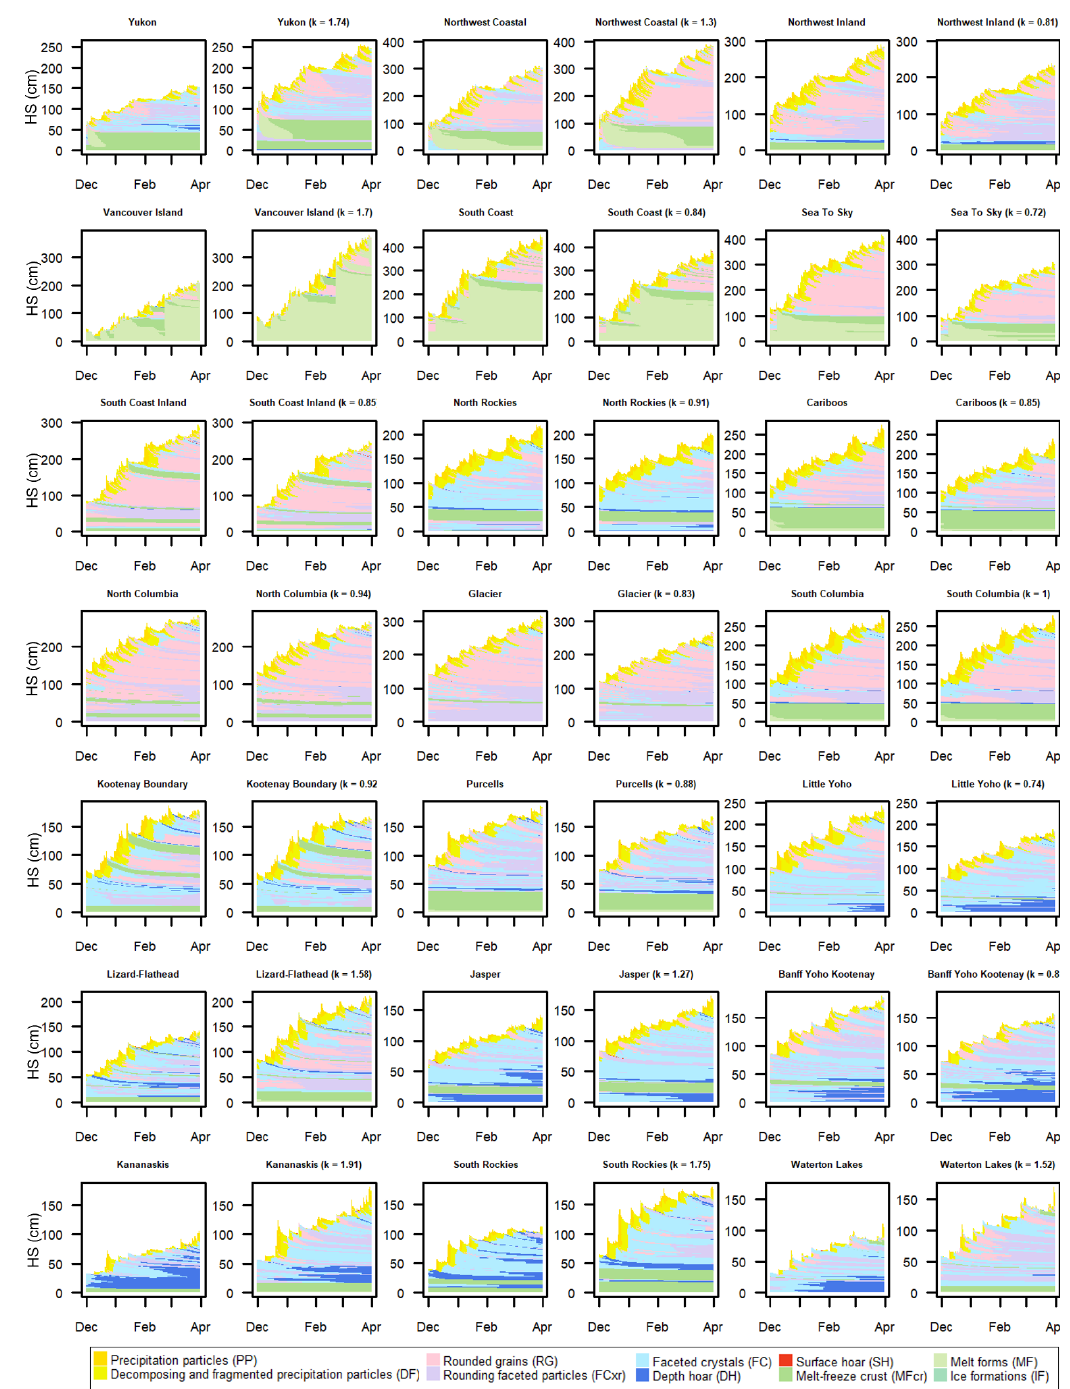
Figure A1. Timelines of simulated snowpack structure before and after precipitation adjustments. Two profile timelines are shown for each forecast region, with the original profiles to the left and the precipitation-adjusted profiles to the right. The precipitation-adjustment factors ( k ) are shown in the title of the adjusted profiles. Snowpack layers are colour-coded by grain type following Horton et al. (2020a).